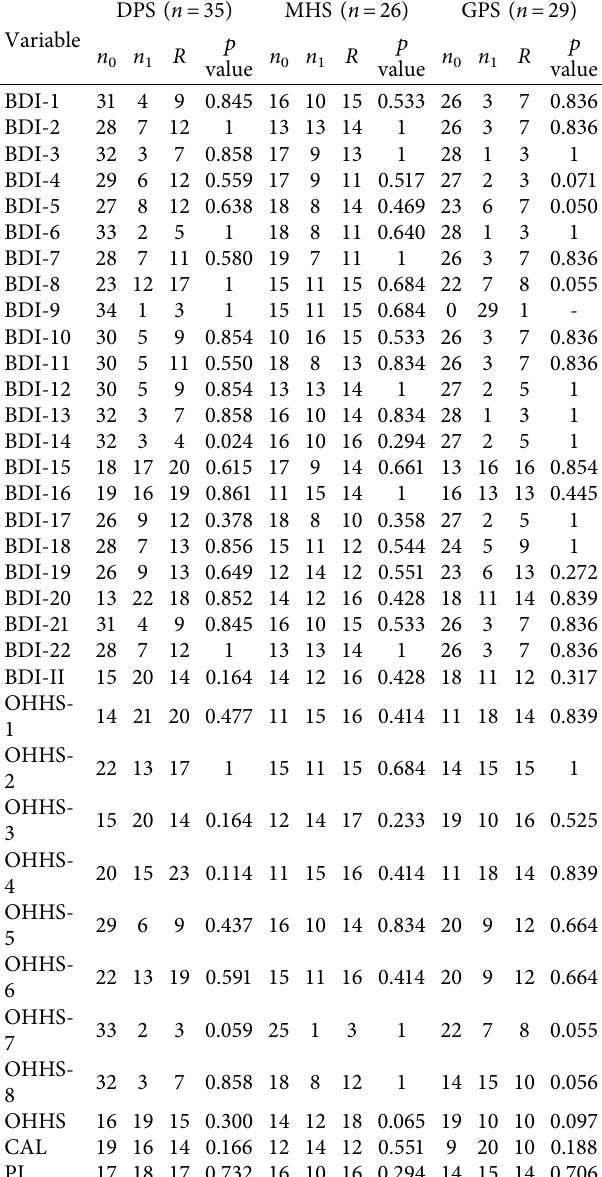
Table 2: Internal consistency reliability through coefficient ordinal omega.